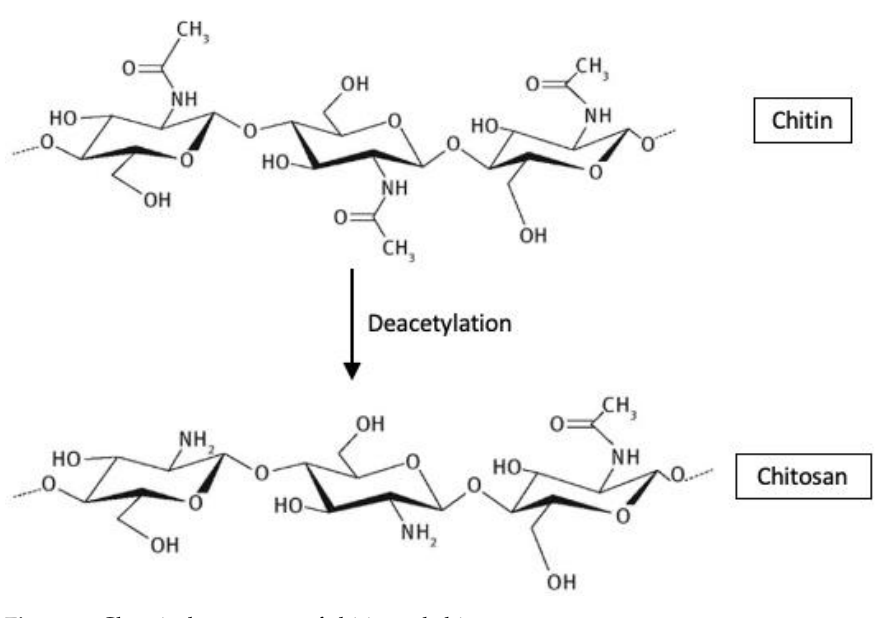
Figure 6. Chemical structures of chitin and chitosan.